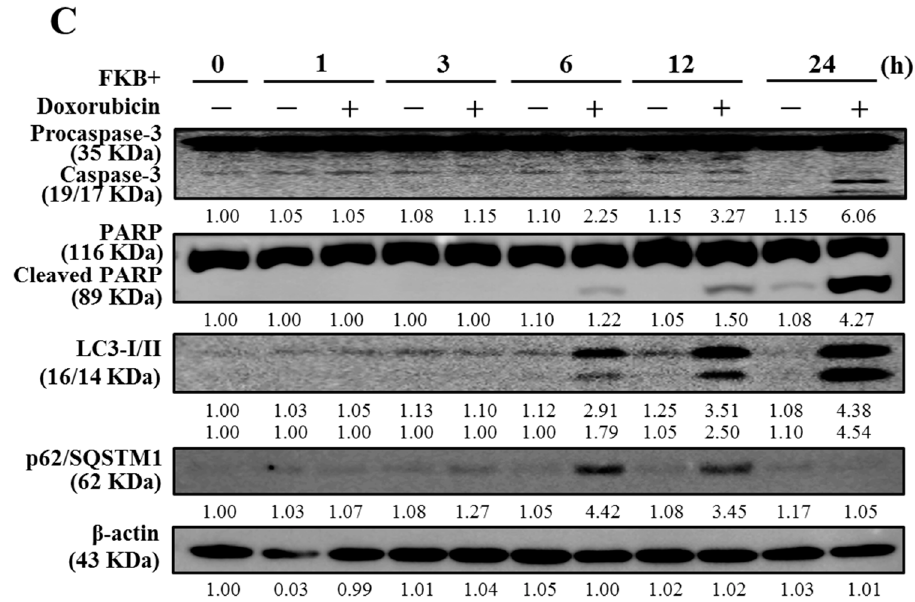
Figure 6. FKB + doxorubicin increased the ratio of AGS cells to Bax / Bcl-2 and Beclin-1 / Bcl-2. Cells undergoing a 24-h co-treatment with FKB (2.5 µ g / mL) and doxorubicin (0.5 µ g / mL). ( A ) FKB + doxorubicin increases the ratio Bax / Bcl-2. Western blot determined changes in the proteins Bax and Bcl-2. Relative changes in the Bax / Bcl-2 ratio have been measured using commercially available quantitative software with a control representing 1-fold (Figure S5A). ( B ) The Beclin-1 / Bcl-2 ratio increases with FKB + doxorubicin. Western blot determined changes in the Beclin-1 and Bcl-2 proteins expression. Relative changes in the Beclin-1 / Bcl-2 ratio were measured by commercially available quantitative software with a control as 1-fold (Figure S5B). ( C ) Time-dependent changes in apoptotic proteins (caspase-3 and PARP) and autophagy markers (LC3-I / LC3-II and p62 / SQSTM1), with co-treatment of 0, 1, 3, 6, 12, and 24 h after FKB (2.5 μ g/mL) and doxorubicin (0.5 μ g/mL) (Figure S5C). Values were expressed as mean ± SD ( n = 3). Significant at ** p < 0.01; *** p < 0.001 compared to untreated control cells. Significant at ## p < 0.01; ### p < 0.001 compared to FKB + doxorubicin-treated